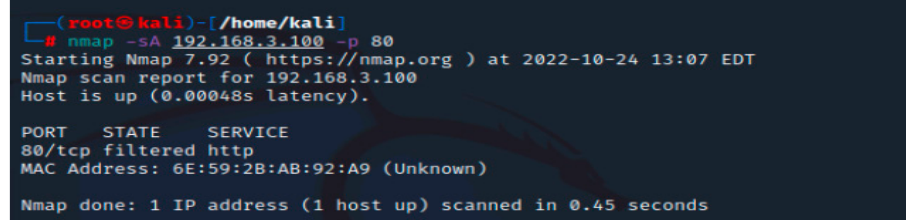
Figure 4. Nmap scan for port 80.